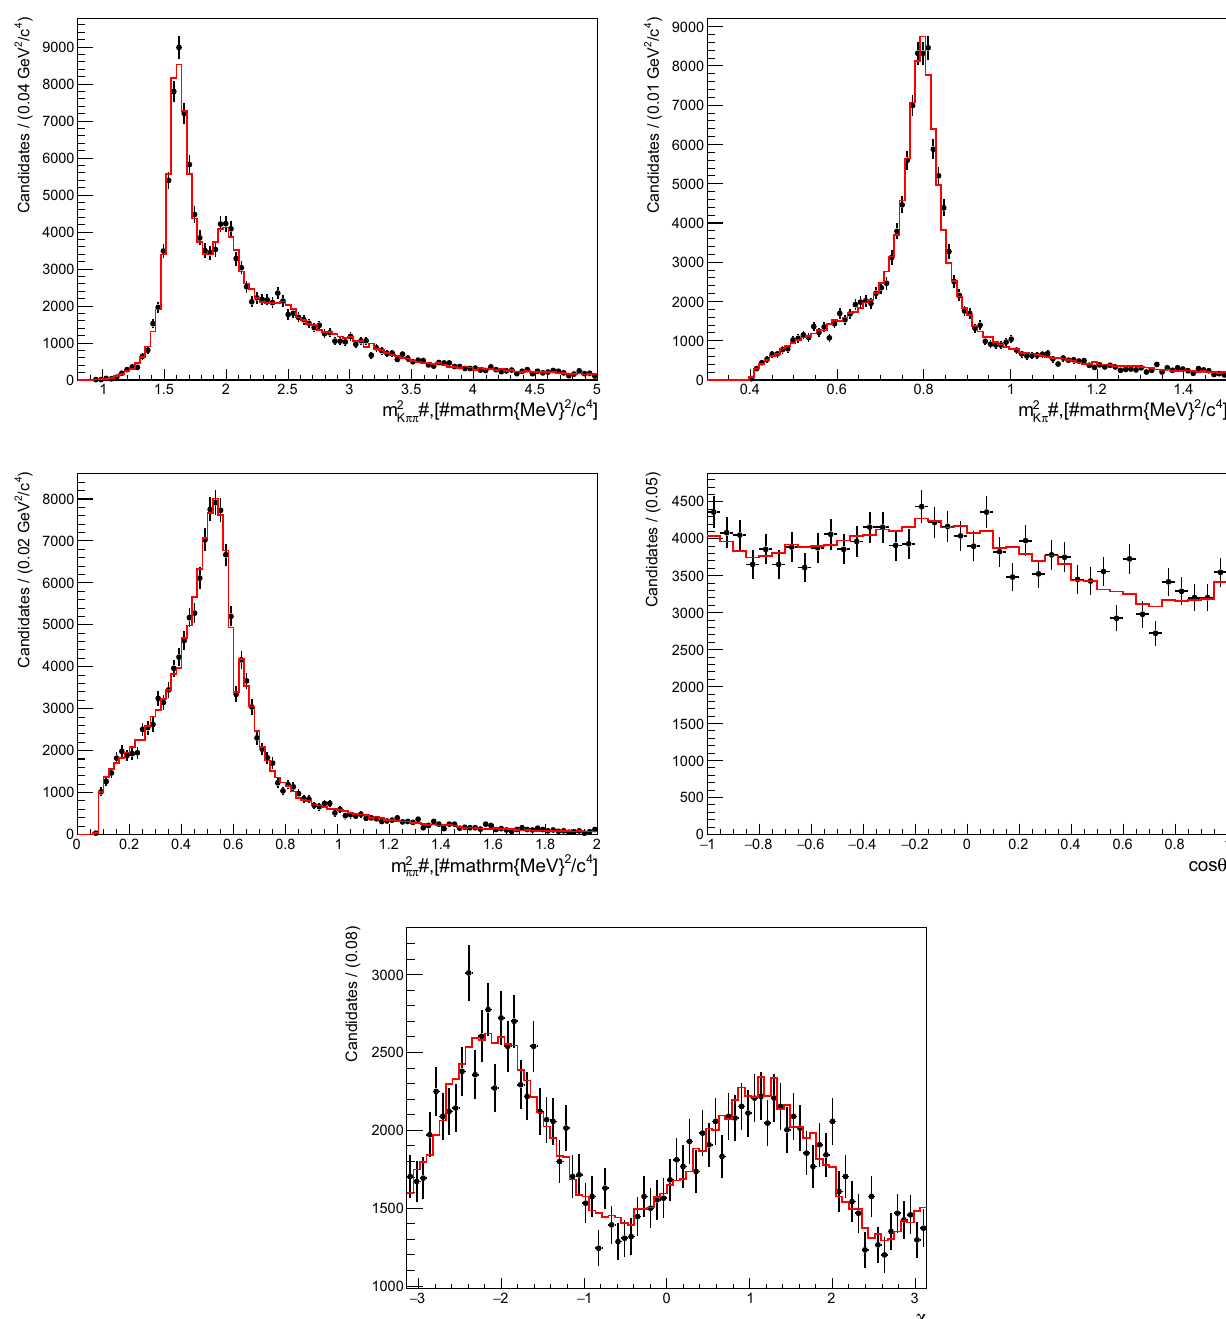
, m 2 , m 2 in Table 2. The red histograms represent the projections of the PDF π − π + ) and K + π − π + K + π −